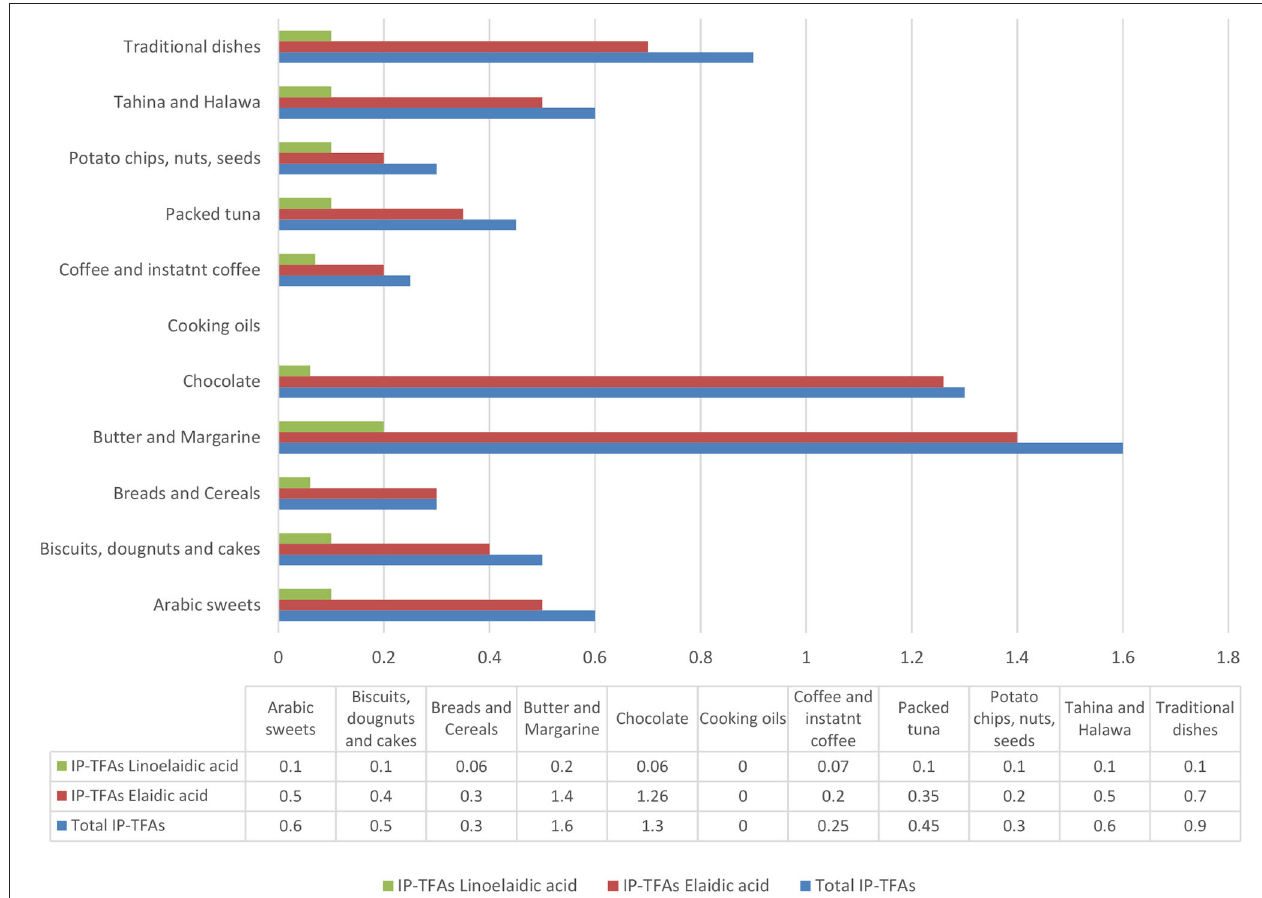
FIGURE 1 | Total IP - TFAs and IP-TFAs averages in all Lebanese food groups tested in this mapping